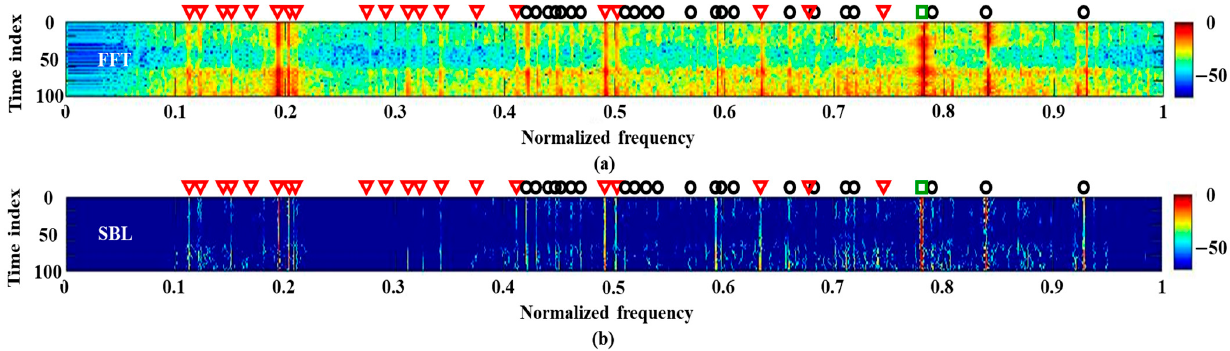
Figure 5. The frequency detection results using a single measurement, which is measured when the experimental ship is around the array: ( a ) FFT; ( b ) SBL.